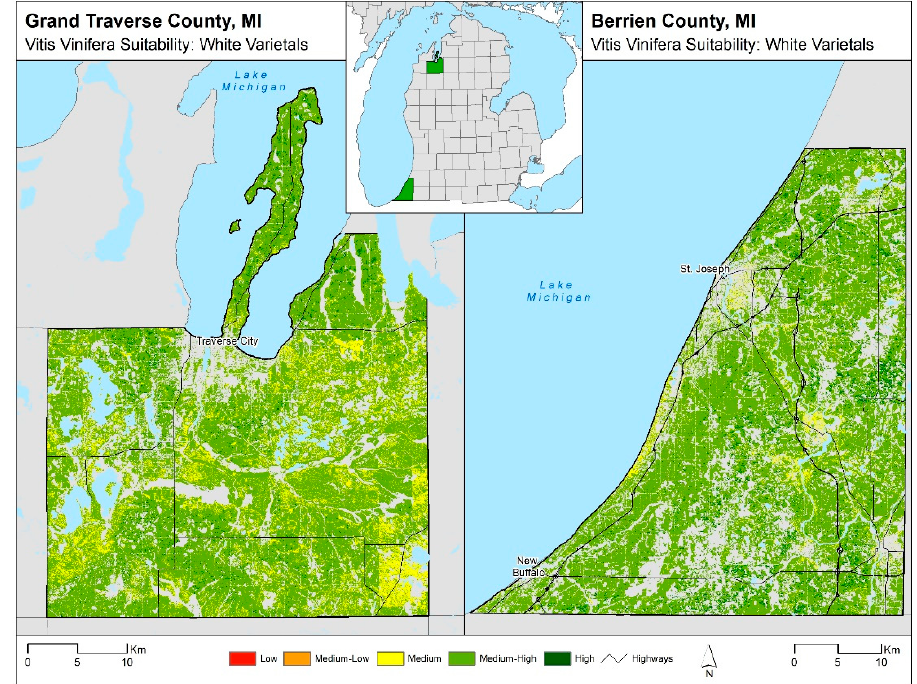
Figure 11. Suitability modeling results for white vinifera varietals across two of the seventeen studied counties. Example one ( left ) is Grand Traverse County in northwestern MI. Example two ( right ) is Berrien County in the southwest portion of the state.